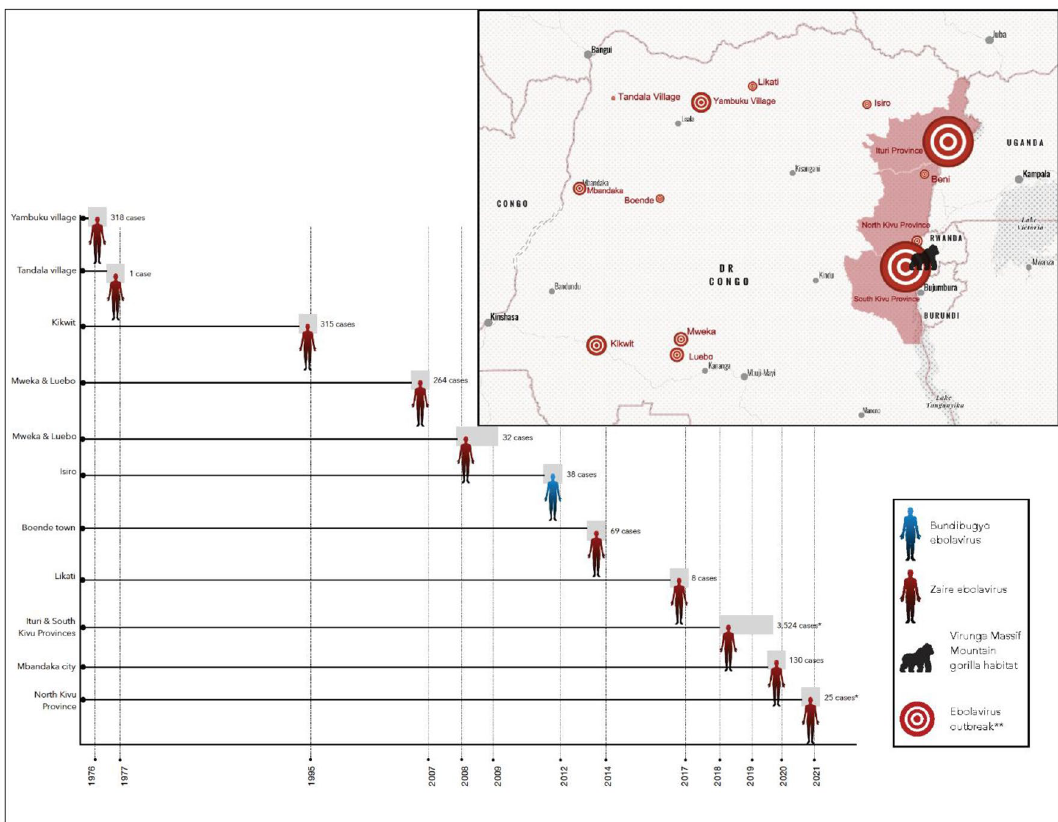
Figure 1. Timeline and locations of human Ebola virus outbreaks in the Democratic Republic of Congo (DR Congo). Outbreak data from: Centers for Disease Control and Prevention (2022). Map created with ArcGIS Online (Version 2.8), Esri Inc. https:// www. esri. com/ en- us/ arcgis/ produ cts/ arcgis- online/ overv iew. *pooled from multiple outbreaks. **size of circle represents size of ebolavirus outbreak in local geographic